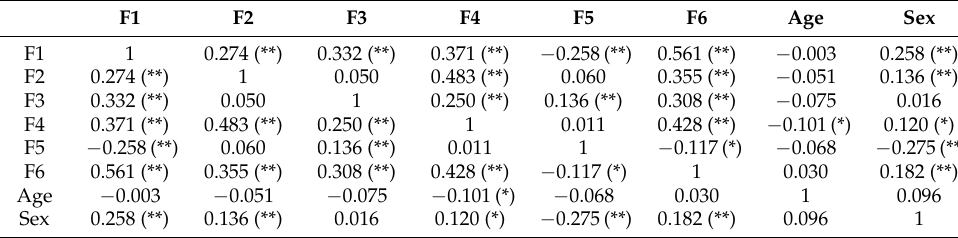
Table 4. Pearson bivariate correlations; * sign ≤ 0.05; ** sign ≤